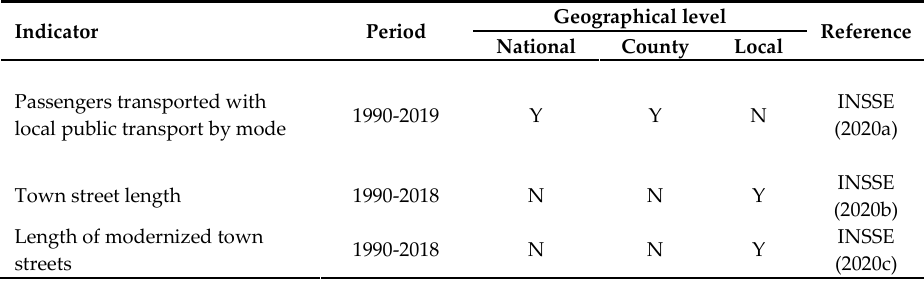
Table 1: Transport infrastructure and urban mobility indicators employed in our study